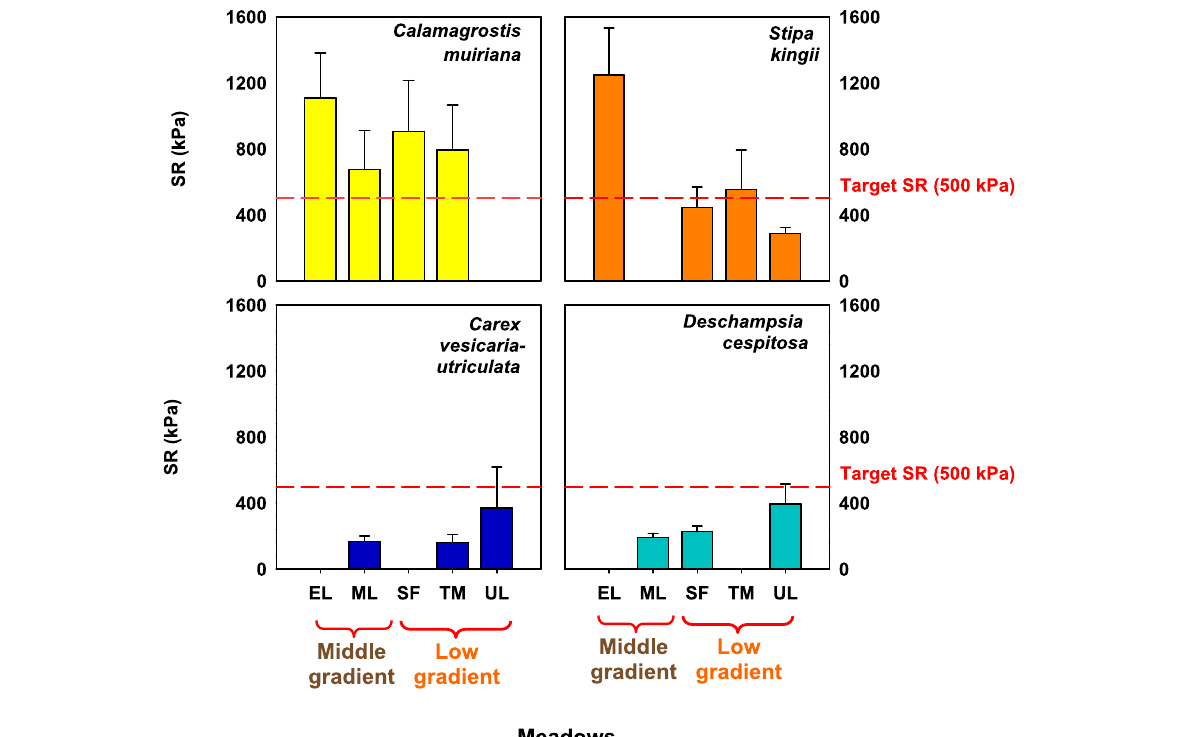
Fig. 3 Mean soil resistance (SR) by plant community type (PCT) among meadows sampled over a 3-week study period in July, 2013 ( n = 252). Dashed line indicates SR minimum value (500kPa) needed to support a horse with rider or mule with load without incurring physical soil disturbance. Error bars represent plus one standard error (SE) across plots within a PCT and meadow. X-axis displays meadows of two topographic gradient classes. Middle gradient meadows (left): Emeric Lake (EL) and Middle Lyell (ML). Low gradient meadows (right): Snow Flat (SF) Tuolumne Meadows (TM), and Upper Lyell (UL). Missing bars indicate a PCT was not present in that